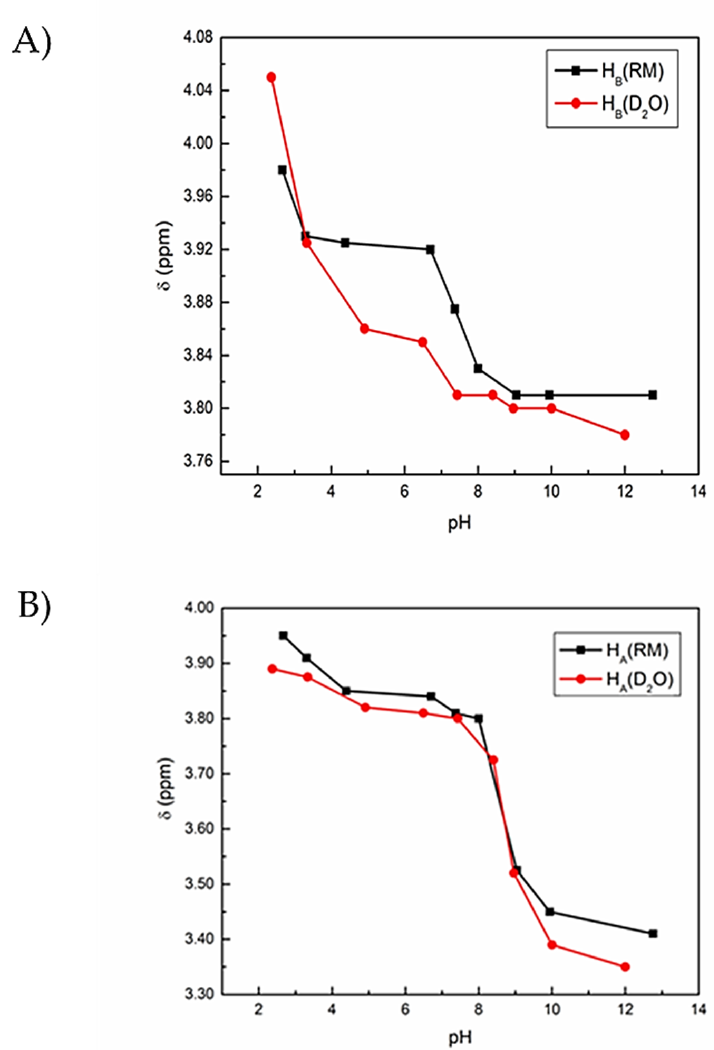
Figure 3. Chemical shifts of GG as a function of pH in D 2 O and RM samples based on 1 H NMR spectroscopic studies of GG at varying pH values. RMs of size w 0 10 were formed with 200 mM solutions of GG in D 2 O. Error bars on the graph are smaller than the symbols used. ( A ) 1 H NMR chemical shift values of protons B (CH 2 near N-terminus) of GG measured at different pH values in D 2 O, with the proton labeling scheme shown in Figure 1C. ( B ) 1 H NMR chemical shift values of protons A (CH 2 near C-terminus) of GG measured at different pH values in RMs, with the proton labeling scheme shown in 1C.